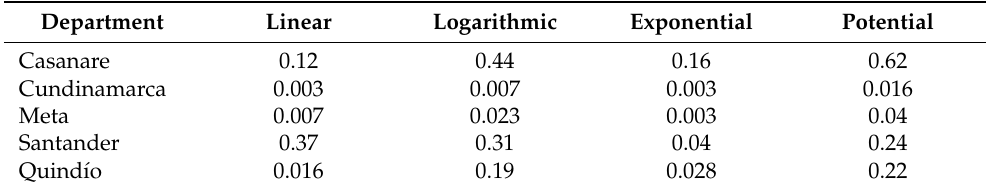
Table 1. R 2 value when correlating MRW with the length of tertiary roadway network between villages and districts with their municipal capital.